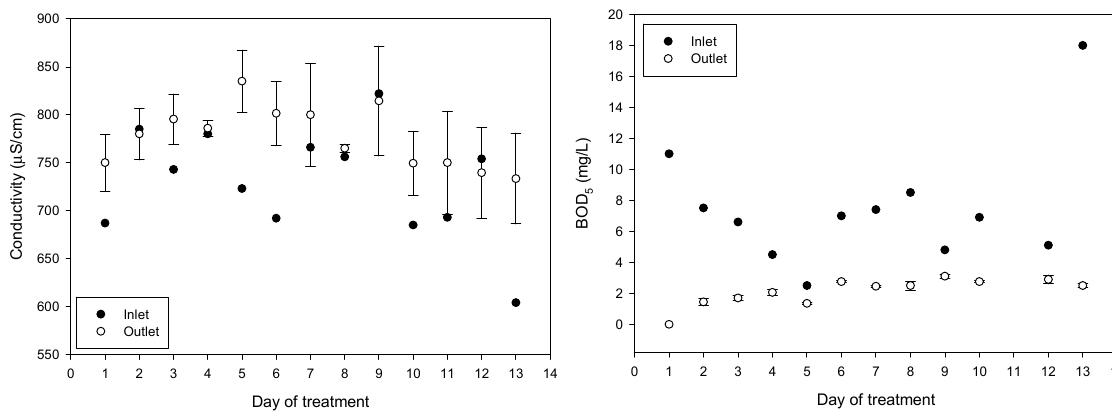
Figure 6. pH, turbidity, electrical conductivity, and BOD 5 variations throughout the 13 days of treatment (mean values with standard deviations).